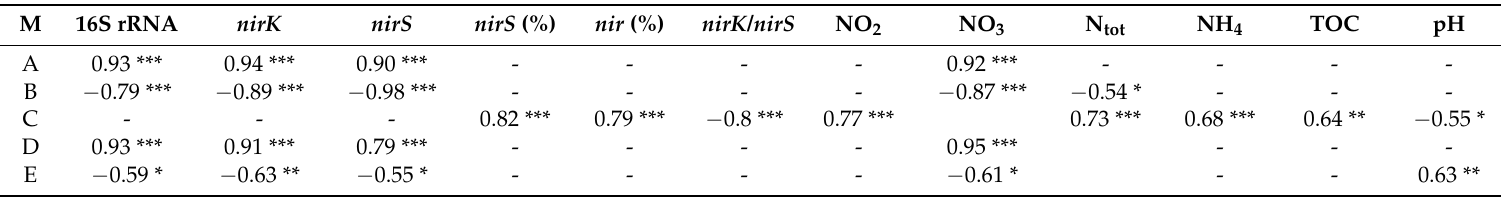
Table A5. Statistically significant ( p < 0.05) correlations between pMEN modules (M), evaluated gene characteristics (16S rRNA and nirK gene copy numbers, nirS , nirK , and total nir gene proportions— nirS (%), nirK (%) and nir (%), respectively—and ratio of nirK and nirS genes ( nirK / nirS ) in filter material microbial community), and influent quality